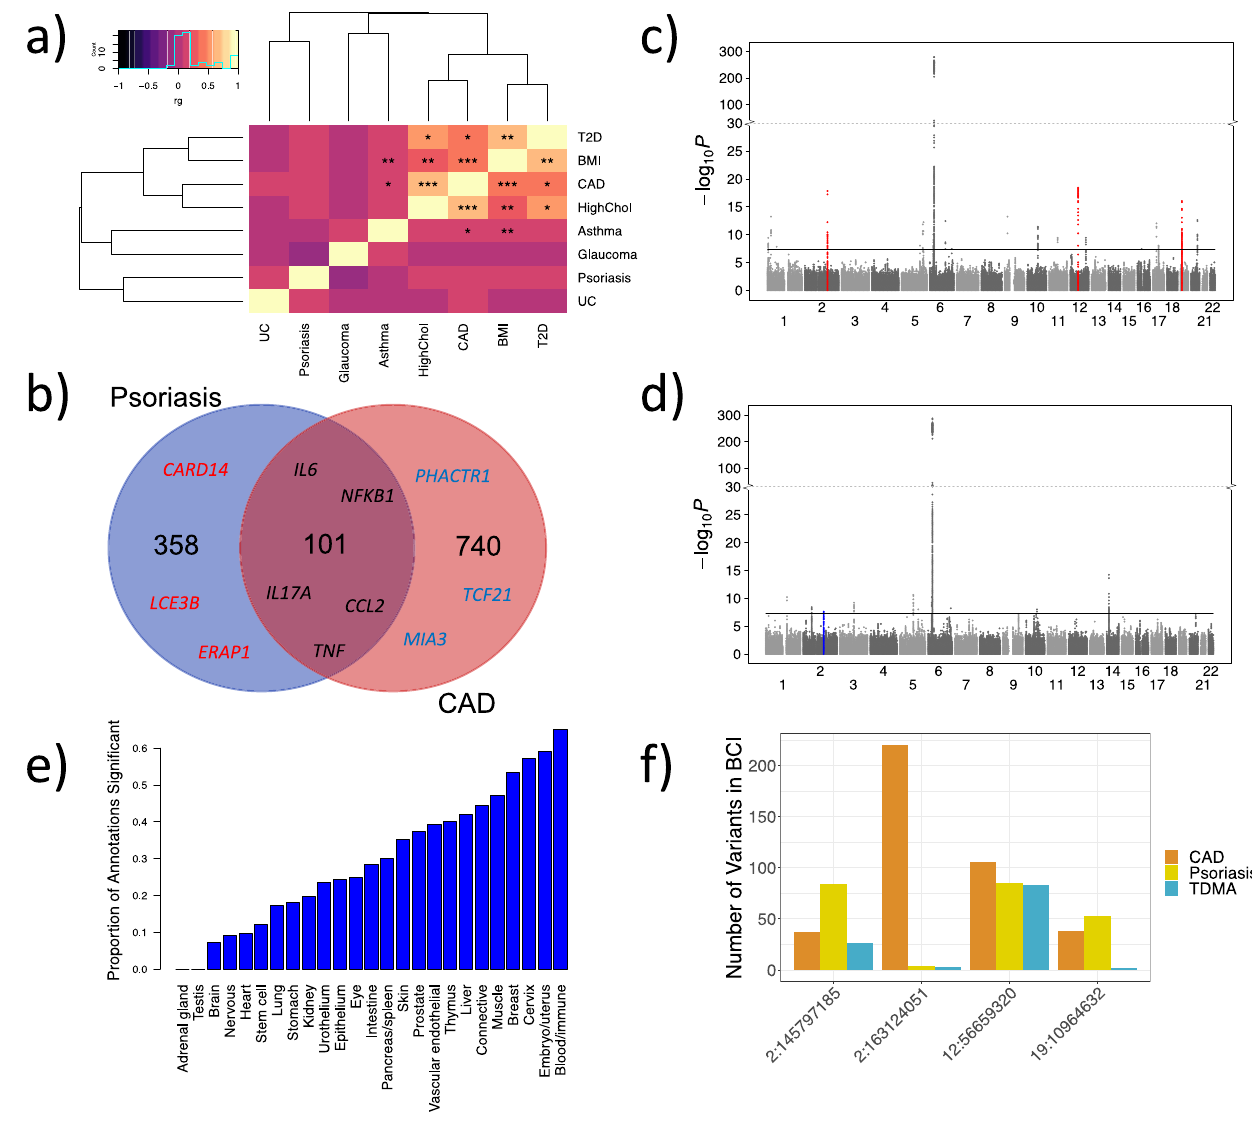
Fig. 1 | Shared genetic/genomic associations between psoriasis and CAD. a Heatmap of genetic correlations between psoriasis, CAD and six other traits, calculatedby applying linkage disequilibriumscoreregression (LDSC)tosummary statistics from the UK Biobank. The color scale indicates genetic correlation (r g ), from strongly negative (purple) to strongly positive (yellow). *FDR<0.01, **FDR< 1×10 − 10 , ***FDR<1×10 − 20 . b Venn diagram illustrating the number of shared and distinct genes, with overall association score >0.1 in OpenTargets, involved in psoriasis and CAD. Examples of shared and distinct genes are overlaid; notably many of the shared genes are responsible for immune response. c Manhattan plot of shared (same directionof effect) psoriasis/CADTDMA signals, showing markers that are more signi fi cant in TDMA than for either trait. The three loci we identi fi ed that are suggestive signi fi cant ( p <1×10 − 4 ) for both traits (meeting all our criteria)